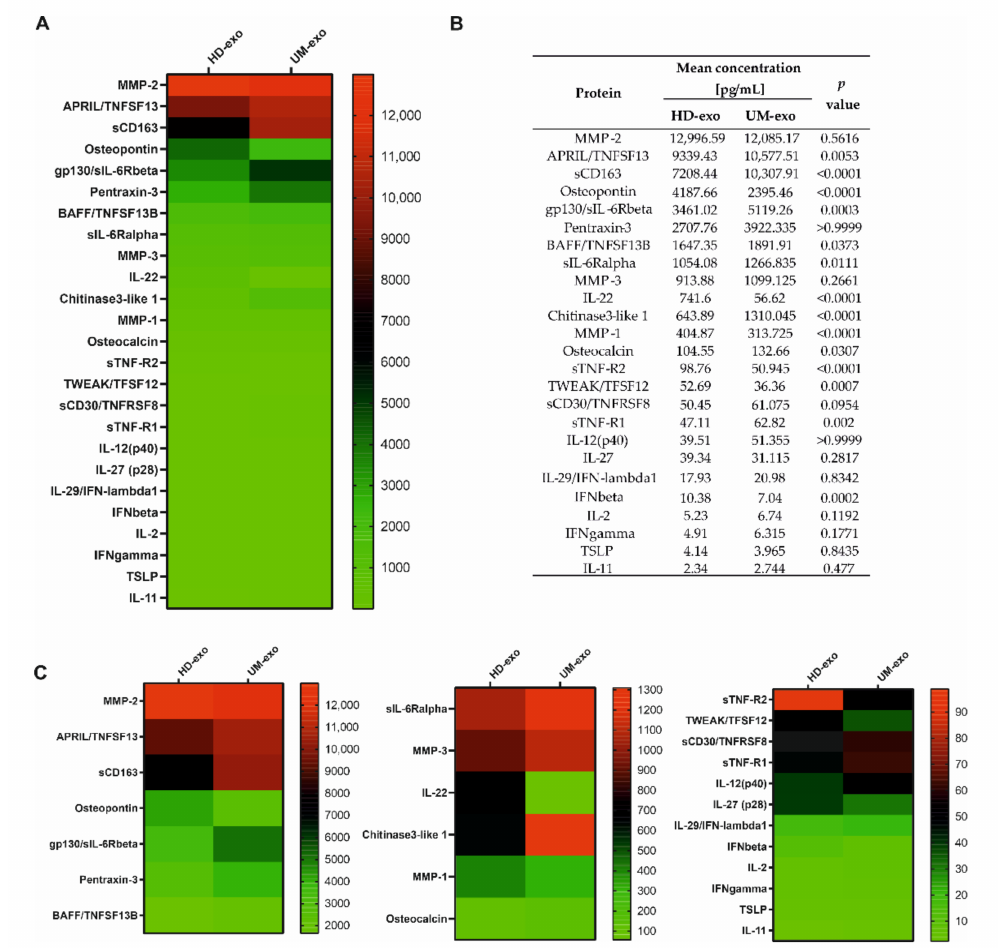
Figure 2. The general comparison of immunomodulatory protein in exosomal cargo in healthy donors and UM patients. All the concentrations are displayed in (pg/mL), only the proteins effectively detected are shown. ( A ) Heatmap representing mean concentrations of all the analyzed cytokines in HD-exo ( n = 20) and UM-exo ( n = 20) groups; ( B ) table showing mean concentrations and p -values indicating the statistical significance; ( C ) for better visualization of the differences in cytokine concentrations, the heatmap was divided into three panels with a distinct concentration range: 13,000–2000 pg/mL, 1400–100 pg/mL, 100–0 pg/mL. The p -value was calculated with the unpaired t -test or Mann-Whitney